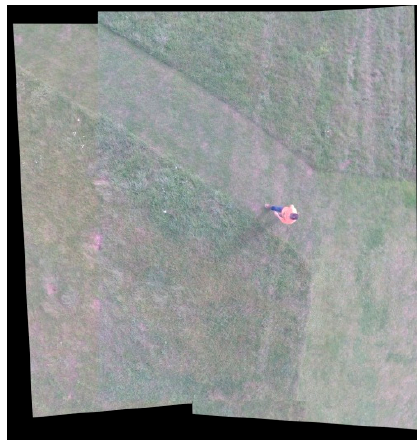
Figure 10. The correction results after relative orientation and geometric correction of two stereograms.